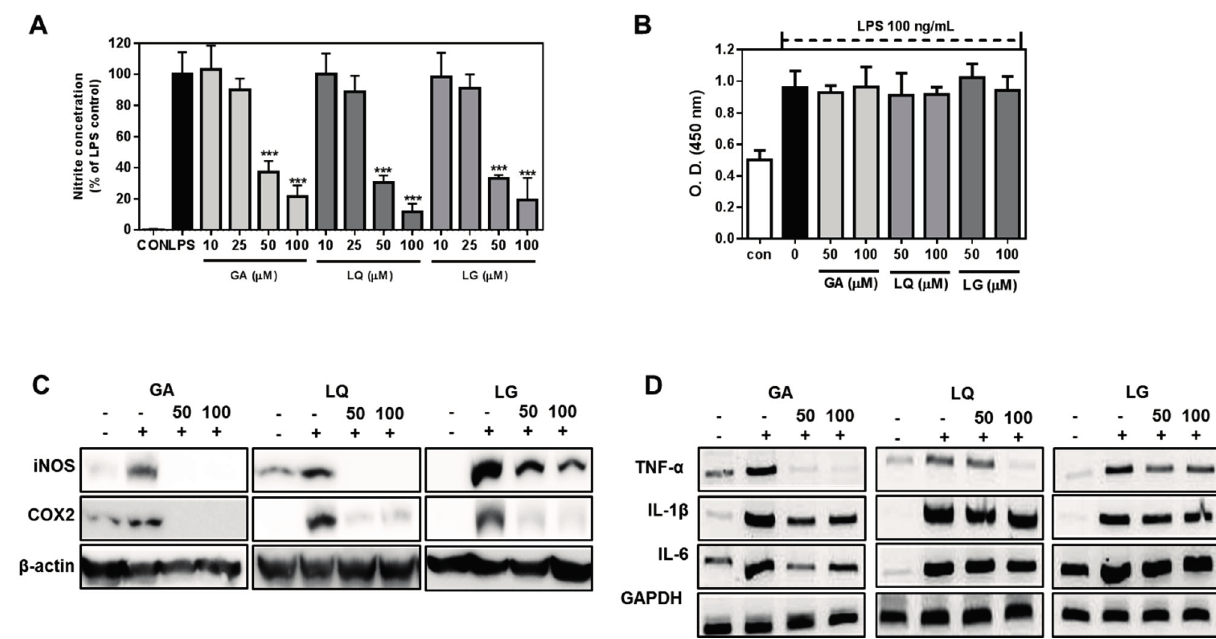
Figure 4. GA, LQ and LG suppressed the NO production and pro-inflammatory gene expression in LPS-stimulated BV2 cells. ( A ) Cells were exposed to each compound (50 and 100 μ M) for 24 h in the presence of 100 ng/mL LPS. Cell viability was measured by theCCK-8 assay kit; ( B ) Cells were exposed to each compound (10 to 100 μ M) for 18 h in the presence or absence of 100 ng/mL LPS. NO production was measured as nitrite concentration in the culture media; ( C ) Cells were stimulated with 100 ng/mL LPS in the presence of 50 and 100 μ M GA, LQ and LG. After 18 h, the levels of iNOS and COX-2 were measured by Western blotting; ( D ) Cells were exposed to 50 and 100 μ M GA, LQ and LG plus 100 ng/mL LPS for 18 h; the level of pro-inflammatory cytokine was determined by quantitative PCR. The results are the means ± SD of three separate experiments. *** p < 0.001 compared to the LPS-treated